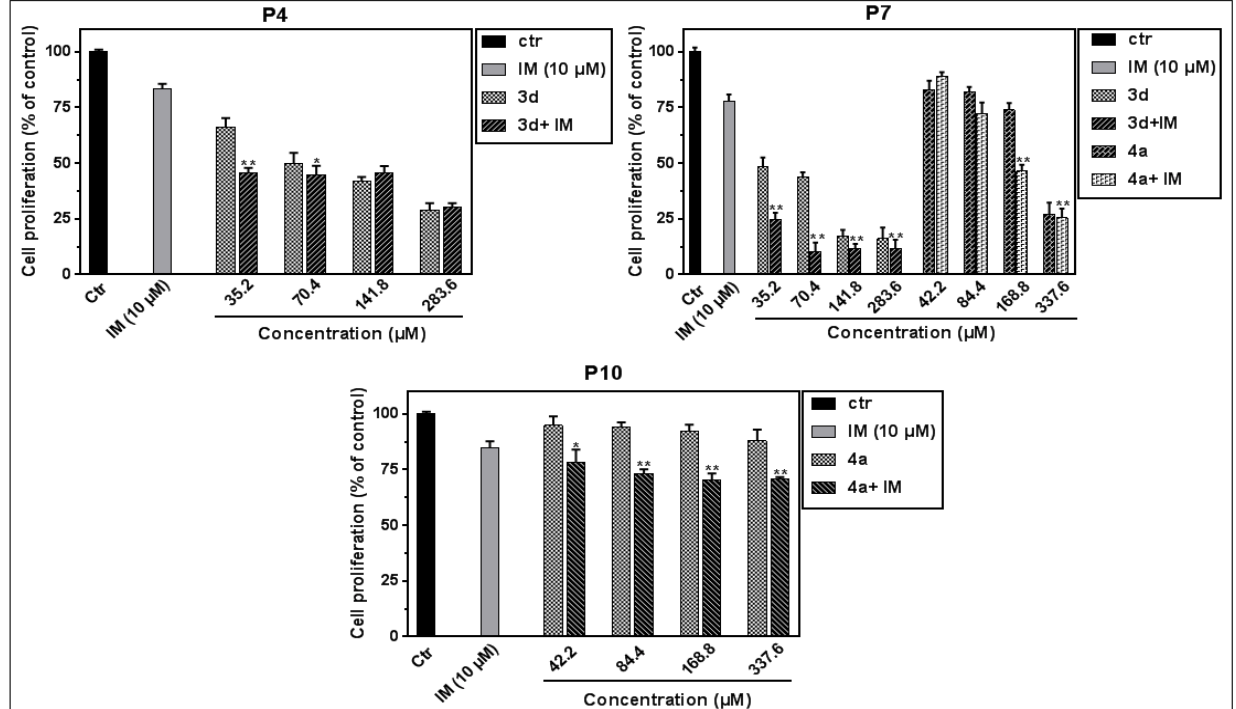
Figure 4. Effect of the compound 3d , 4a and their combination with IM (10 µ M) on patients’ PBMC proliferation. Comparison between the percentage of PBMC proliferation in PBMC treated only with 3d or 4a and cotreated with IM (10 µ M). * p < 0.05 and ** p < 0.01 values; used to compare the percentage of cell proliferation treated with 3d or 4a alone or combined with IM (10 µ M). Data represent the mean ± SEM of two independent experiments performed in triplicate.